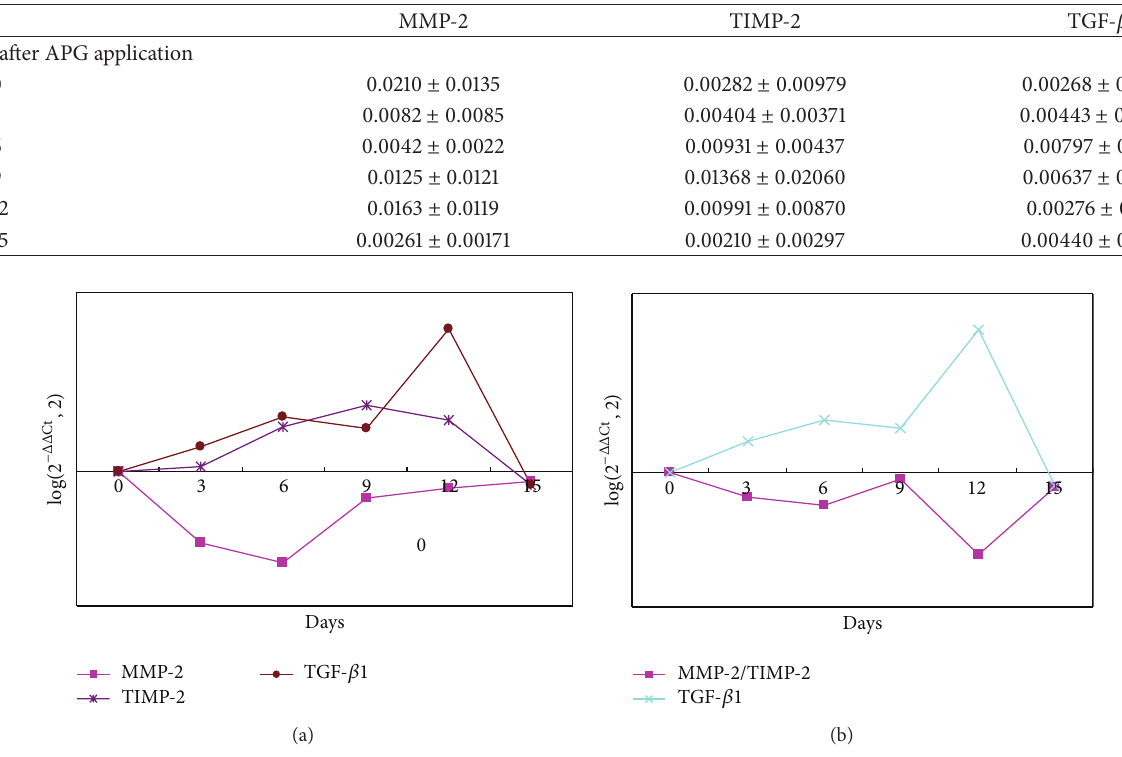
Figure 2: Dynamic changes of the mRNA expression of MMP-2, TIMP-2, and TGF- 𝛽 1 as well as the ratio of MMP-2/TIMP-2 in the granulation tissue of wounds before and within 15 days after the APG